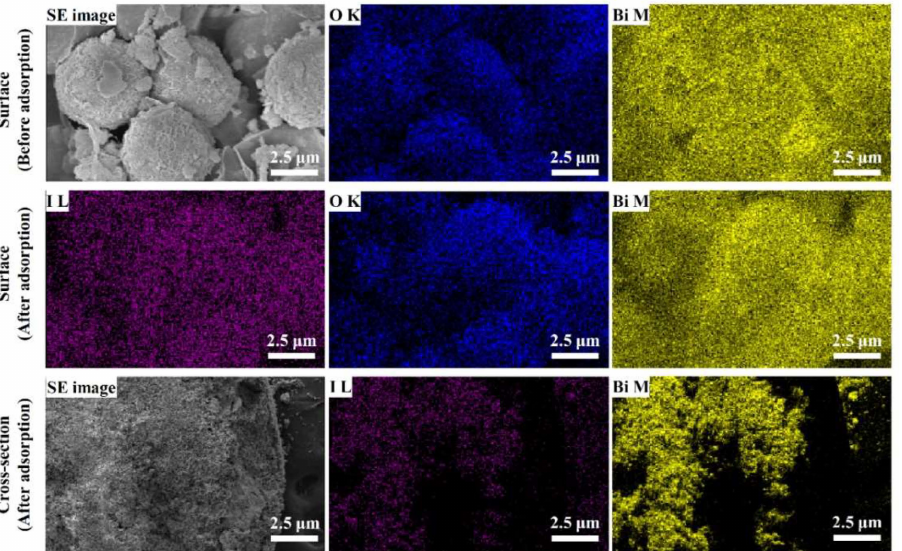
Figure 9. Element mapping images obtained by scanning electron microscopy of Alg–BO before and after iodide adsorption (blue: oxygen, yellow: bismuth, and magenta: iodide).